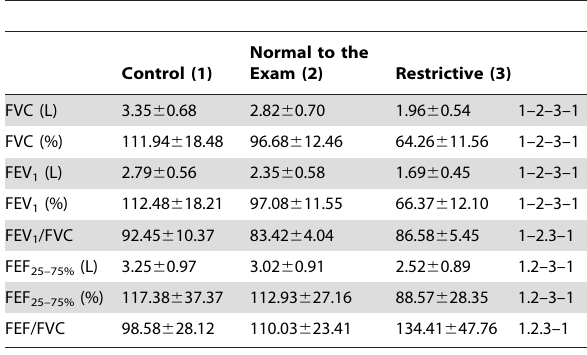
Table 2. Spirometric parameters obtained in the groups studied using this exam as a reference.